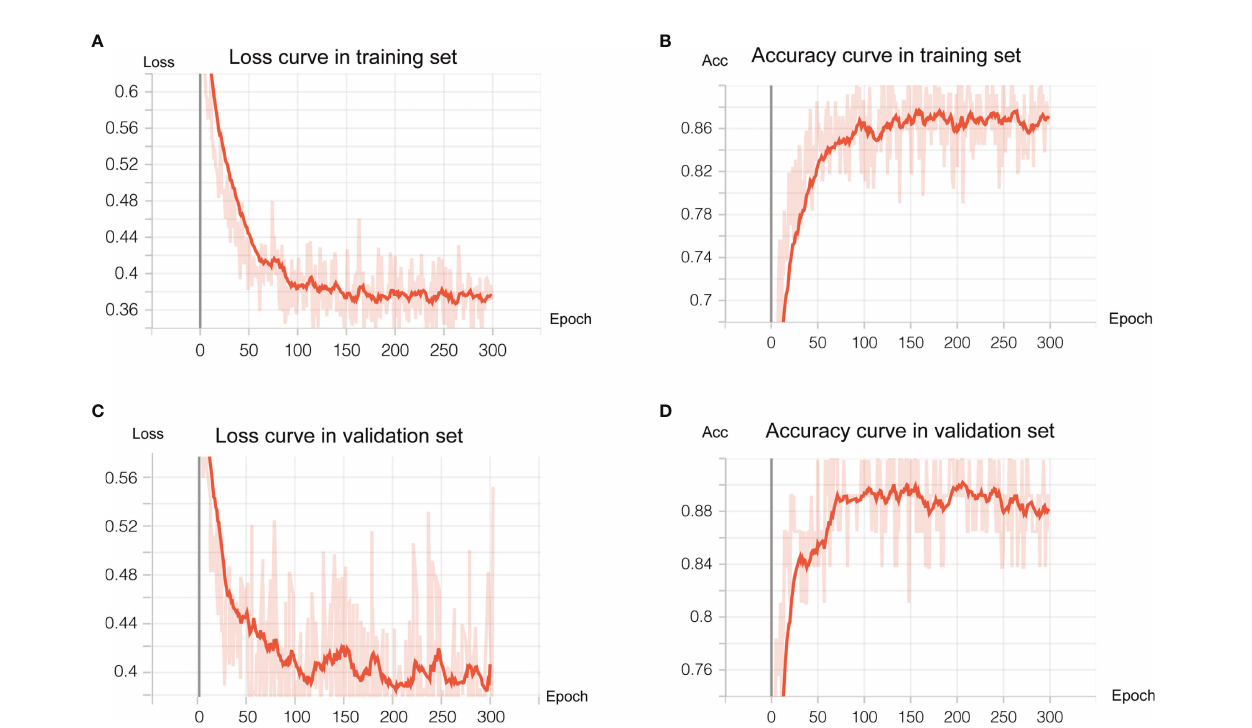
FIGURE 3 | Deep learning training and validation. We trained 300 epochs and training and validation loss reached convergence at around 100 epochs. (A, B) showed loss curve of the transfer model in the training set and validation set, respectively. (C, D) showed the accuracy curve of the transfer model in the training set and validation set, respectively.